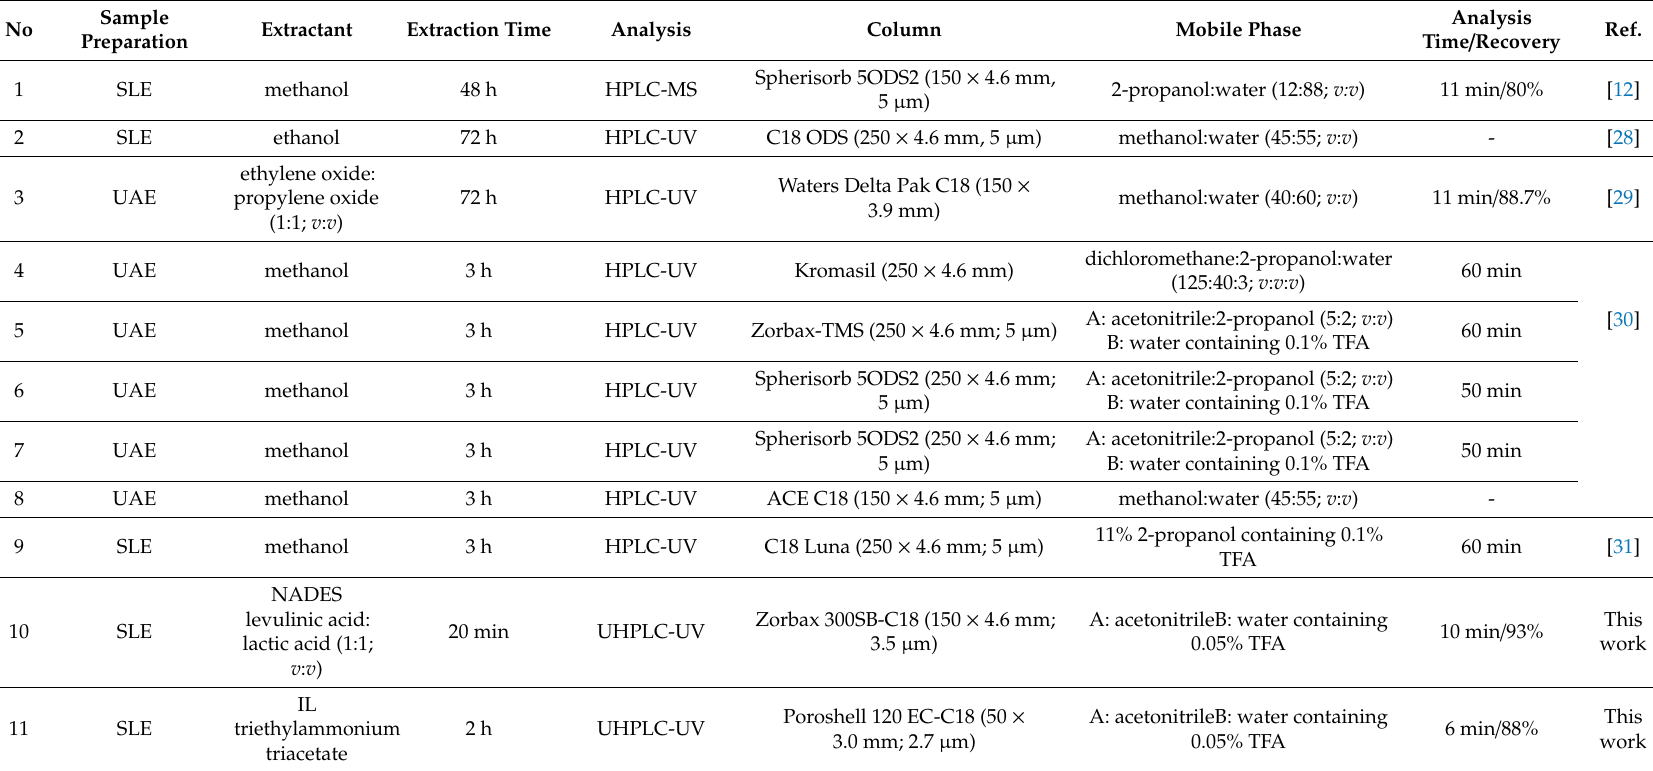
Table 3. Comparison of NADES-SLE-UHPLC-UV and IL-SLE-UHPLC-UV procedures with other reported